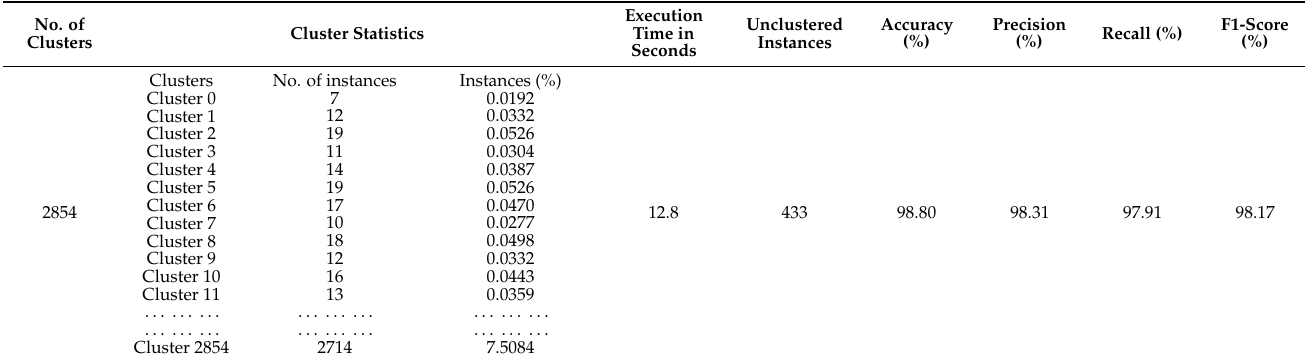
Table 6. Algorithm performance factors for Diagnosis